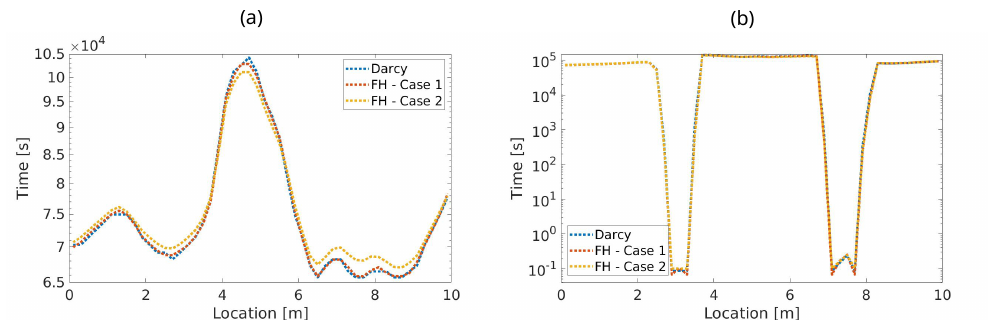
Figure 5. Breakthrough curves for Scenario (a) and Scenario (b) and the three cases.